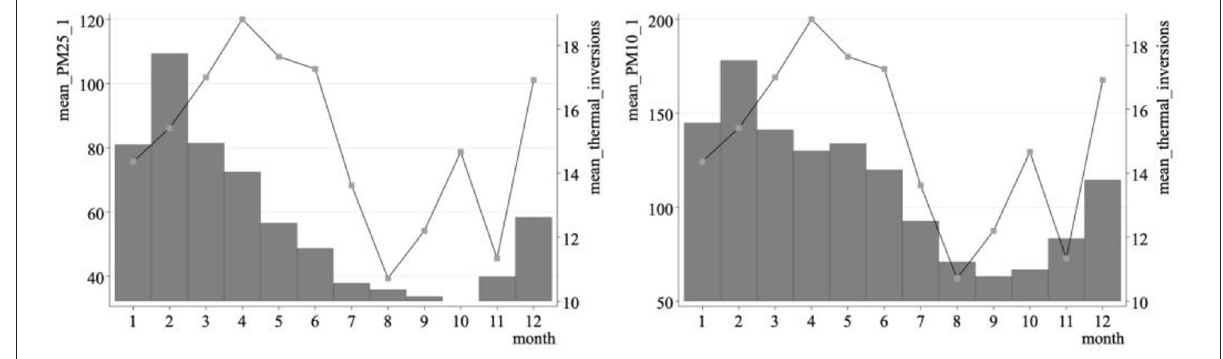
FIGURE2 The relationship between the number of inversion days per month and air